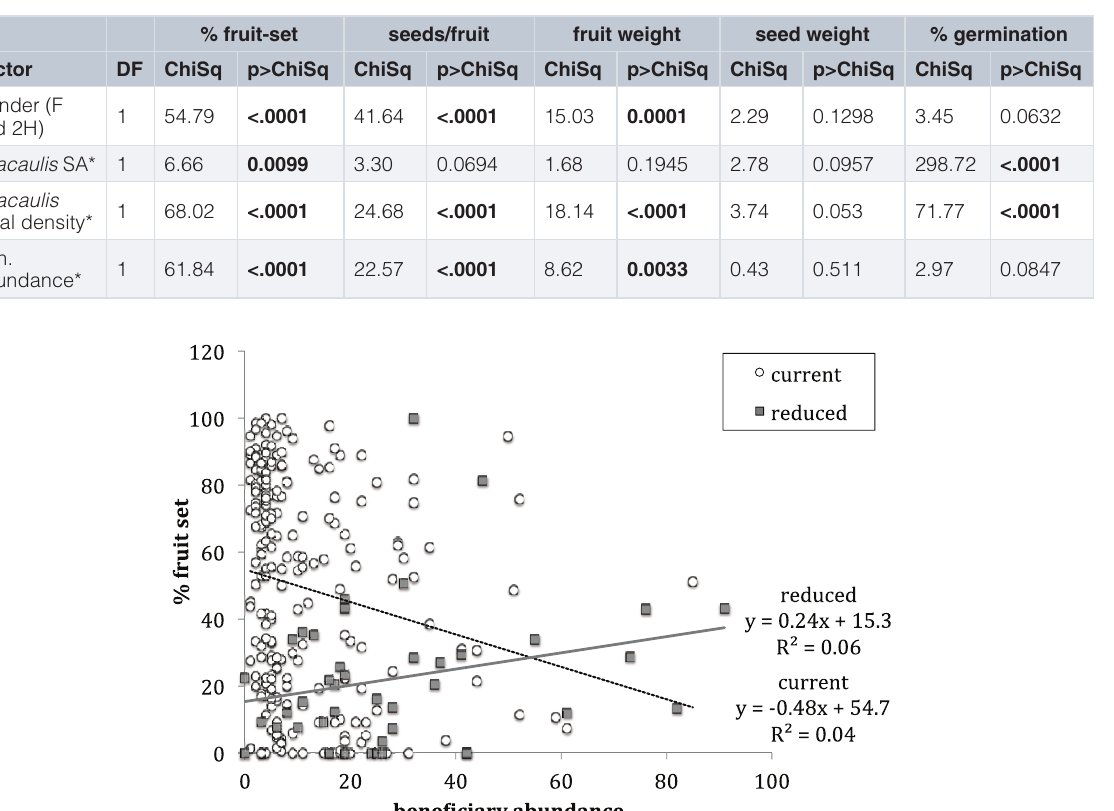
Table 3. Summary of GLM results testing the effect of gender on measures of reproductive success under the reduced pollination regime with covariate measures of S. acaulis surface area (SA), S. acaulis floral density, and beneficiary abundance indicated by *. Reproductive measures for hermaphrodites are doubled. Significance is considered at p<0.05 and indicated in bold.